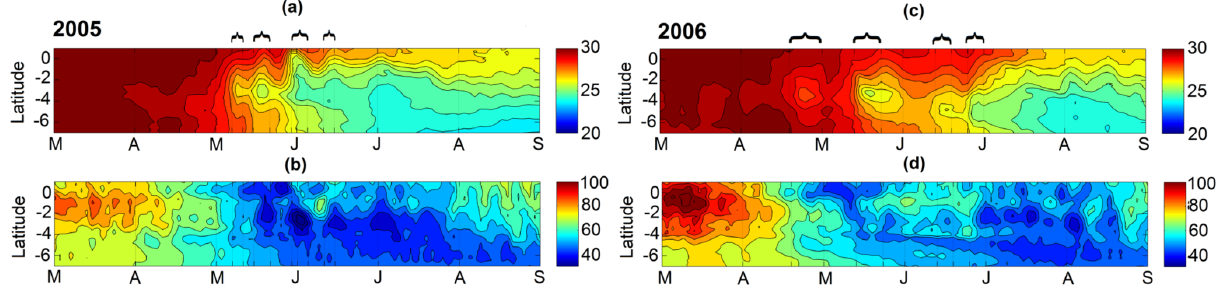
Figure 3. (a, c) Latitude–time diagram of the sea surface temperature ( ◦ C) averaged between 5 and 12 ◦ E; (b, d) latitude–time diagram of the 20 ◦ C isotherm depth (m) averaged between 5 and 12 ◦ E from 1 March to 31 August 2005 (left panels) and 2006 (right panels). The cooling episodes are indicated by the black brackets.